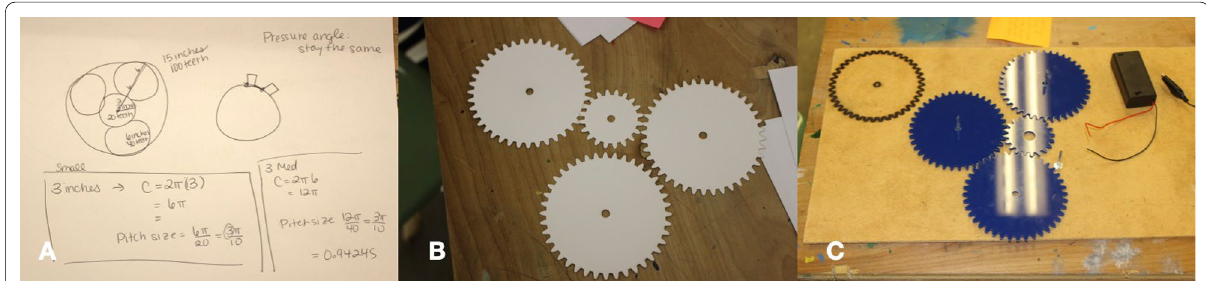
Fig. 2 A Teachers’ drawings of the Round and Round gear tooth relationships for their planetary gear system; B first draft of the planetary gear system, made on the laser cutter with card stock; C acrylic gears cut from their designs for the planetary gear system (Photos: